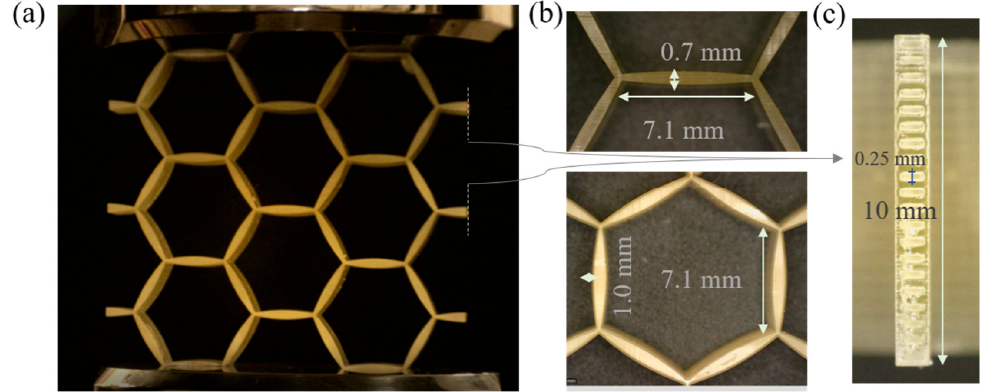
Figure 3. Experimental testing of micro-fabricated multiscale honeycomb lattices ( a ). Elements with a length of 7.1 mm and different inner element geometries are depicted in ( b ). A 10 mm out-of-plane thickness with a hollow-width feature size of 0.25 mm is depicted in ( c ), rotated by 90° with respect to ( a ).